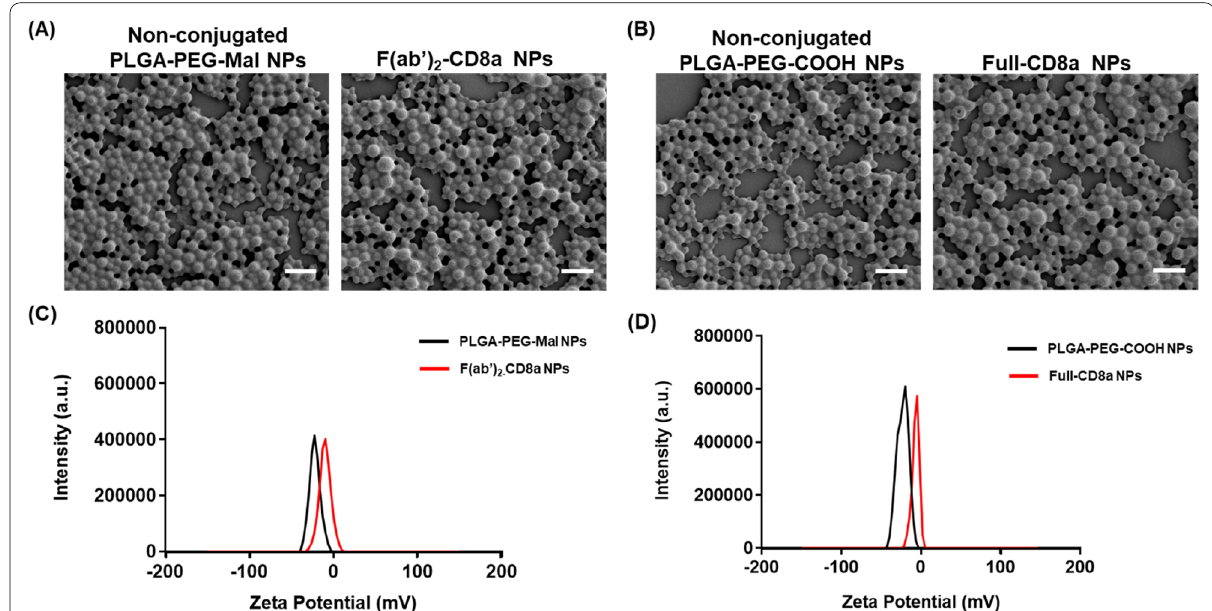
Fig. 1 Morphological and zeta potential analysis of the PLGA NPs through scanning electron microscopy (SEM) and dynamic light scattering (DLS). A SEM image of non‑conjugated PLGA‑PEG‑COOH NPs and Full‑CD8a NPs. B SEM image of non‑conjugated PLGA‑PEG‑Mal NPs and